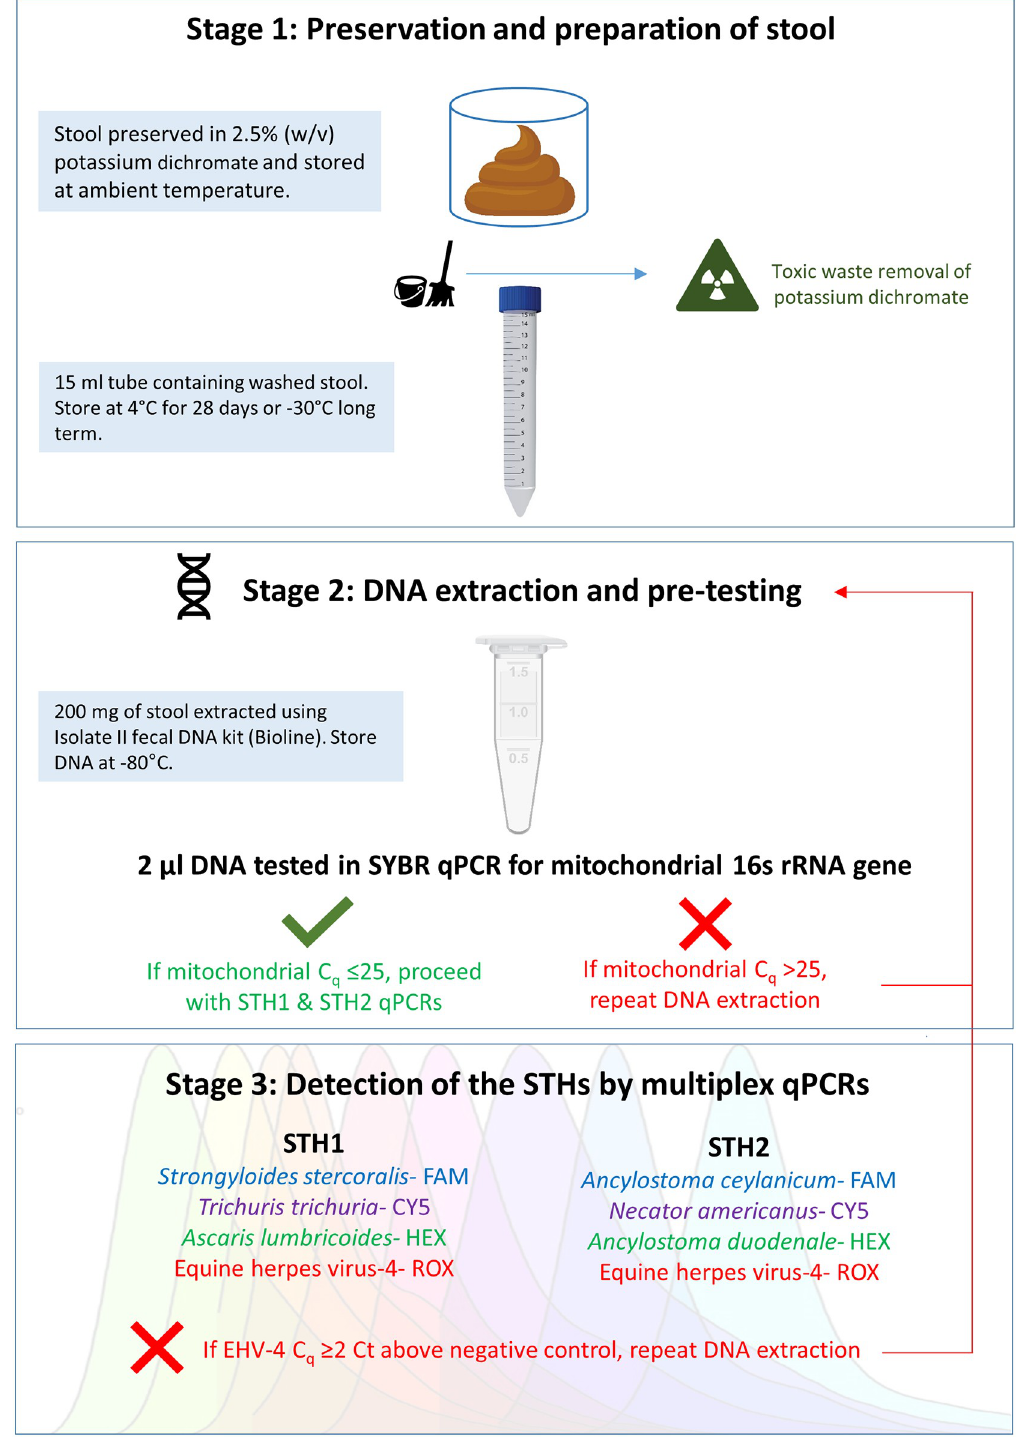
Fig 1. Workflow of the laboratory procedures. The three-staged approach for detection of soil-transmitted helminths in potassium dichromate preserved stool. Images used under license from Shutterstock.com.